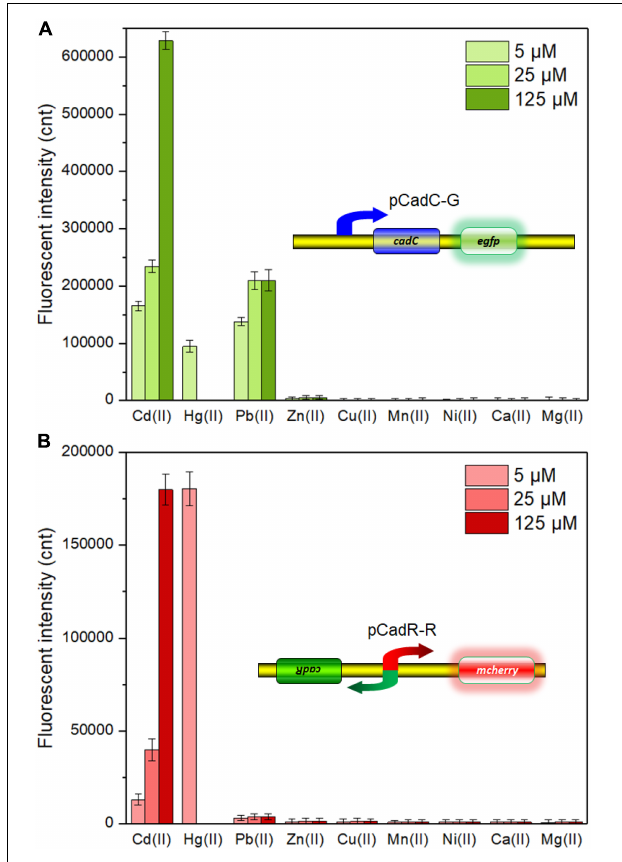
FIGURE 3 | The responses of single-sensing biosensors toward nine different metal ions. After being exposed to 5, 25, and 125 µ M concentrations of the specifically labeled metal ions at 37 ◦ C for 12 h, both of fluorescent signals were determined. (A) TOP10/pCadC-G. (B) TOP10/pCadR-R. The fluorescent signal was indicated as a fluorescence count value (unit = cnt), and fluorescent values were divided by the optical density at 600 nm. Results are the average of at least three independent experiments performed in triplicate. The data values shown for each metal exposure group were obtained by subtracting the control values (with no metal exposure) from the experimental